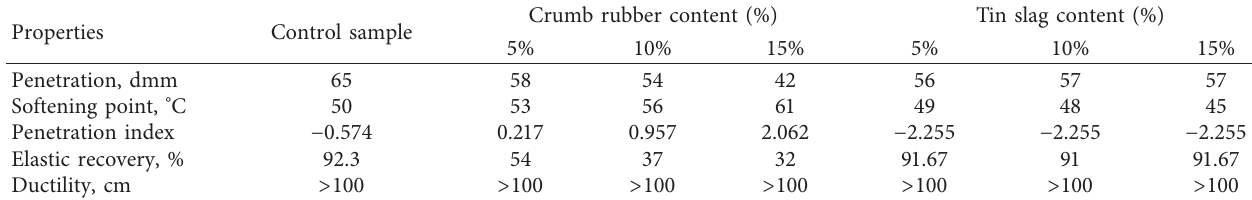
Table 10: Basic properties of asphalt binders.